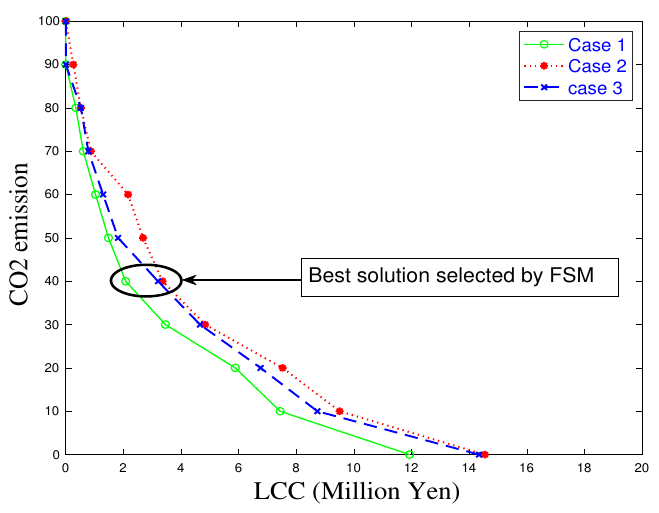
Figure 7. Pareto set of each case.